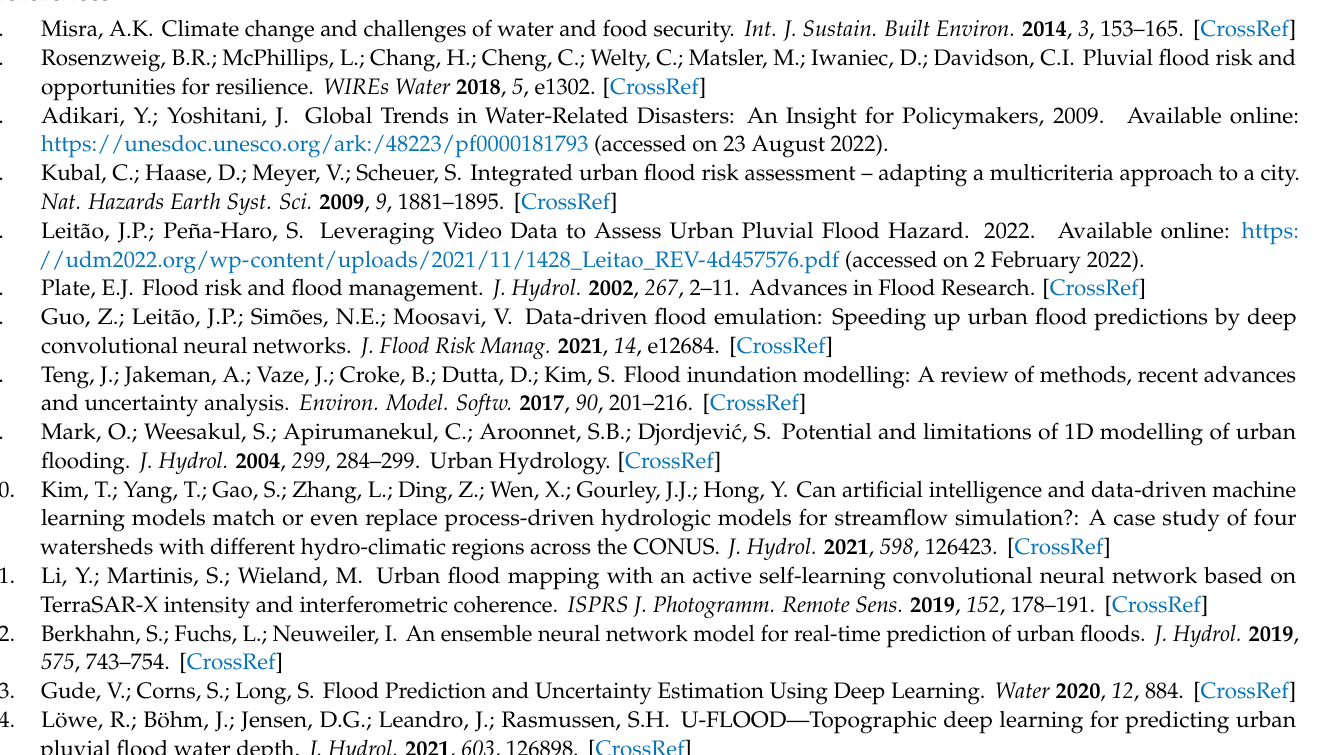
Figure A5. The box plot for the predicted water depth values and their associated per cent error. The predictions are reported for our Deep Flood tested on a steep test catchment and rainfall event tr2_1